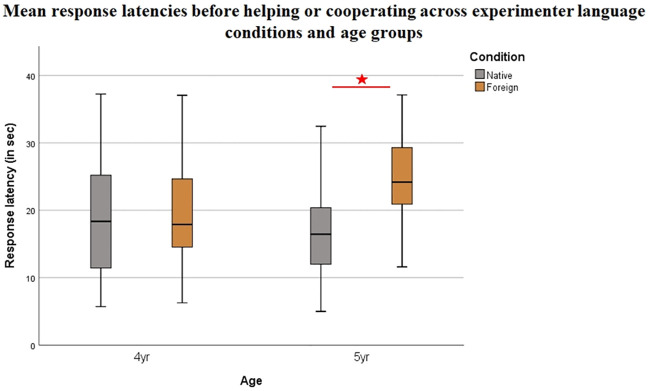
Preschoolers’ mean response latencies across experimenter language conditions and age groups in helping and cooperation tasks combined.Experimenter language had a significant effect on mean response latencies (F(3, 84) = 10.66, p = .002, partial η2 = .12). The effect was stronger at 5 years, when preschoolers showed significantly greater response times in the Foreign condition (MRLForeign5y = 25.14, SDRLForeign5y = 6.53) vs. the Native condition (MRLNative5y = 15.94, SDRLNative5y = 6.29, p = .004).